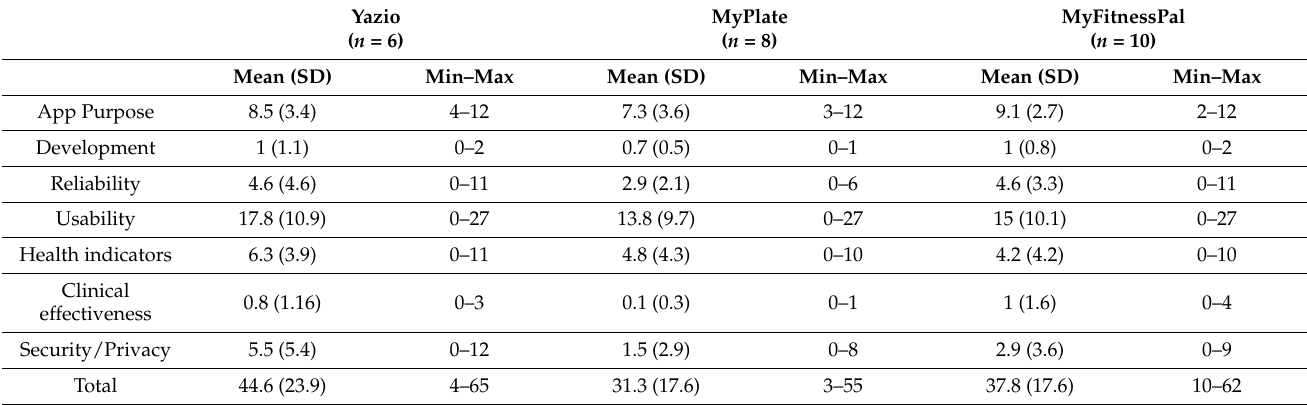
Table 3. Dimension and total score for each evaluated